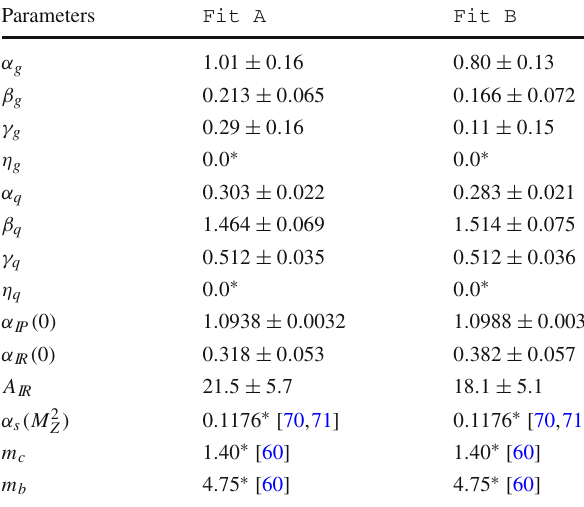
Table 4 Parameters obtained with the different fits at the initial scale = 1 . 8GeV 2 and their experimental uncertainties. Values marked Q 2 0 with (*) are fixed in the fit Parameters